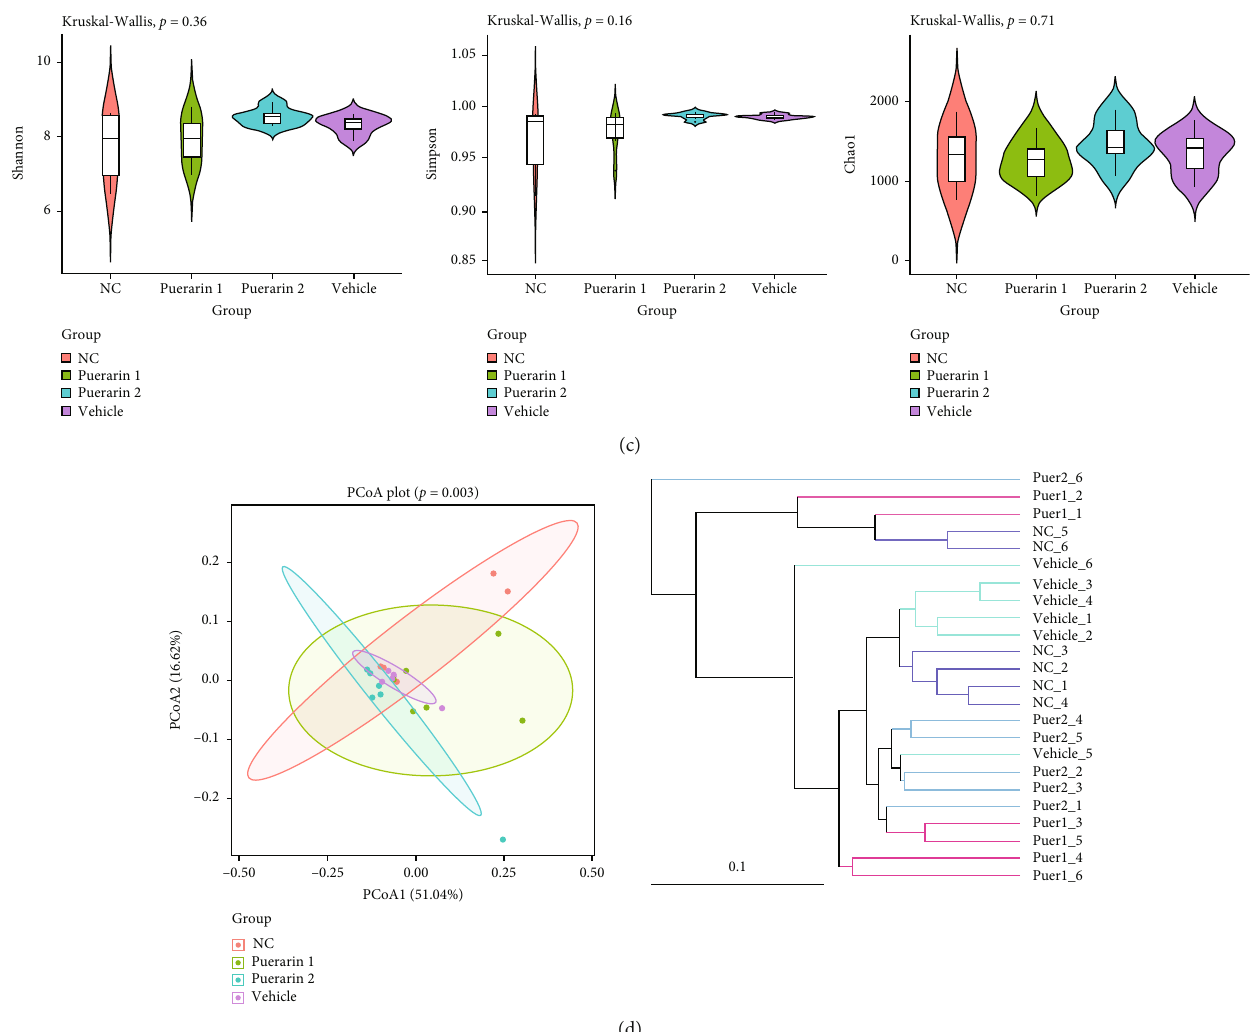
Figure 6: Puerarin modulates the diversity of the gut microbiota in OC rats. Rat feces were collected for 16S rDNA sequencing to analyze the e ff ect of puerarin on the gut microbiota in OC model rats. (a) Venn diagram shows the features of the analyzed feces samples from all groups. (b) Stacked bar chart of the species richness analysis from the family, genus, to species of the detected microbes in the four groups. (c) Alpha diversity analysis, including the Shannon, Simpson, and Chao1 indexes, was used to assess the diversity of the intestinal microbes in the four groups. (d) Beta diversity of the intestinal microbiota was evaluated using principal coordinate analysis (PCoA) and Unweighted Pair Group Method with Arithmetic mean (UPGMA) clustering analysis. OC: ovarian